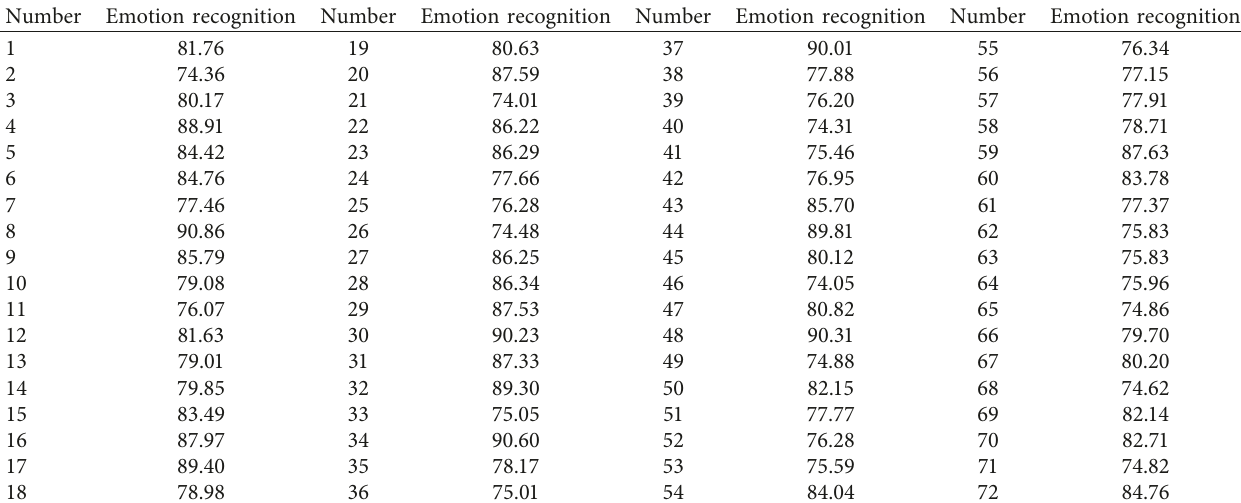
Table 1: The effect of the system on the recognition of emotional factors in college English classroom teaching. Number Emotion recognition Number Emotion recognition Number Emotion recognition Number Emotion